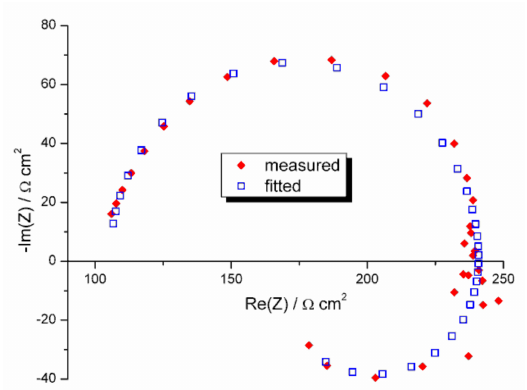
Figure 7. Equivalent electrical circuit applied in the interpretation of the data from electrochemical impedance spectroscopy measurements. R S = resistance of the solution, C EDL = capacitance of the electrical double layer, R T = charge-transfer resistance, L = inductance of the electrode process, R L = resistance connected with the inductance of the electrode process.